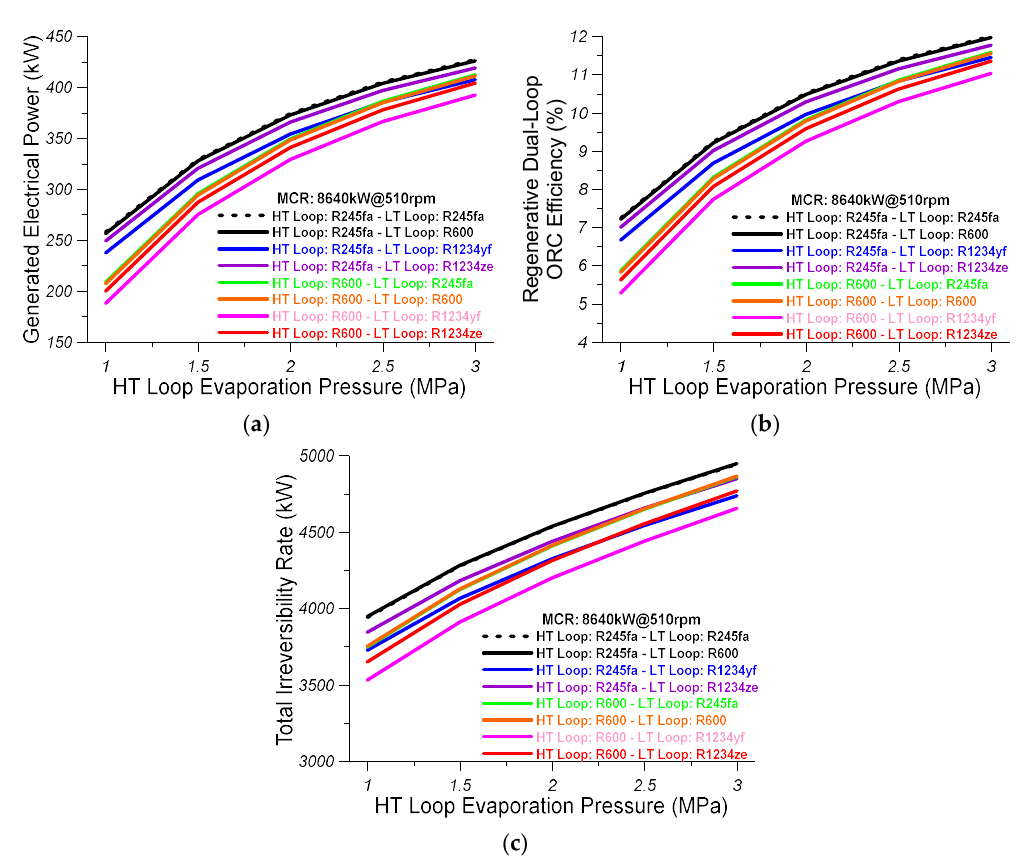
Figure 7. (a) Effect of evaporation pressure of the HT loop on the generated electric power of the regenerative dual-loop ORC; (b) Effect of evaporation pressure of the HT loop on the thermal efficiency of the regenerative dual-loop ORC; (c) Effect of evaporation pressure of the HT loop on the total irreversibility rate of the regenerative dual-loop ORC. Results are given for all the pairs of organic mediums that are examined in the present study.